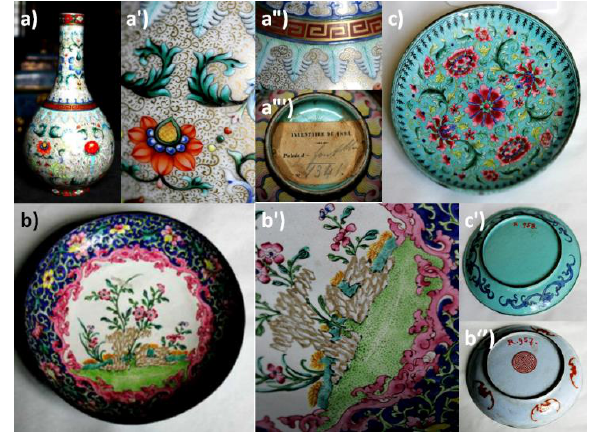
Figure 3. Chinese painted enamelled porcelain and metal wares: ( a ) F1341C (18th century porcelain, a′ to a′′′ details); ( b ) R957 (18th century, b′ detail of the decor and b′′ reverse side); ( c ) R958 (18th century, c′ reverse side).